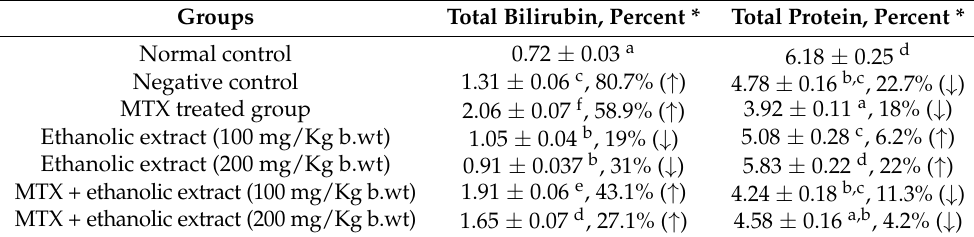
Table 5. Effect of different treatments on total bilirubin and total